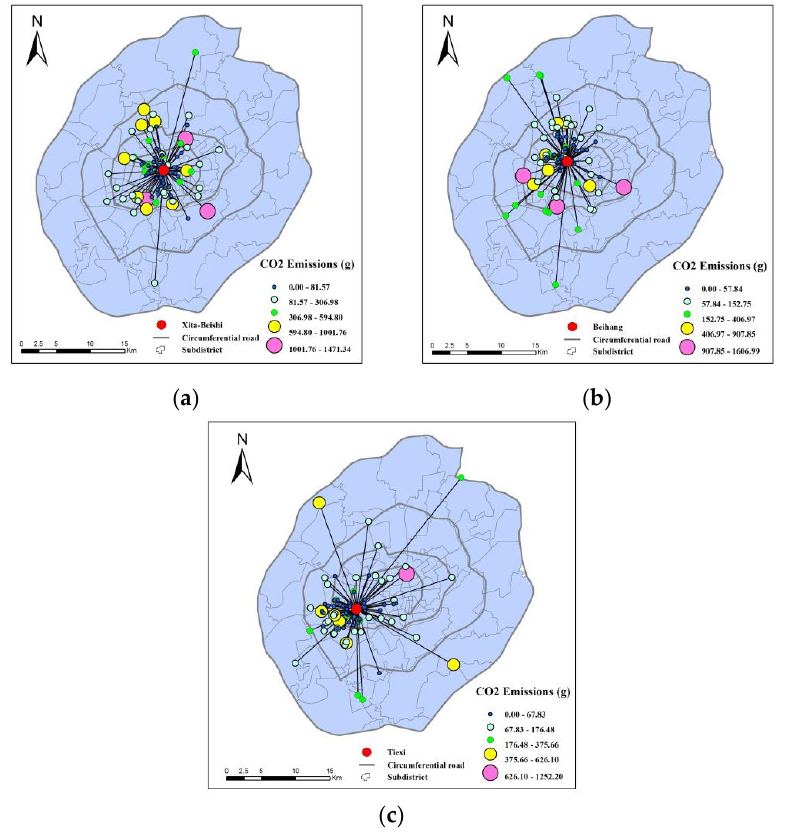
Figure 5. ( a ) CO 2 emissions per trip to Xita-Beishi; ( b ) CO 2 emissions per trip to Beihang; ( c ) CO 2 emissions per trip to